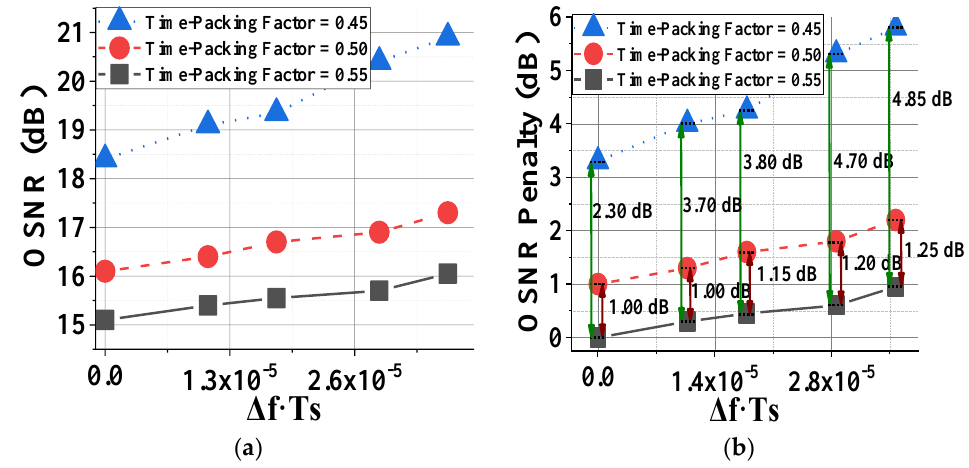
Figure 9. The performance of required OSNR and OSNR penalty versus linewidth symbol rate (Δf·Ts) under the time -packing factor changes of 0.45~0.55: ( a ) required ONSR versus Δf·Ts; ( b ) OSNR penalty versus Δf·Ts.